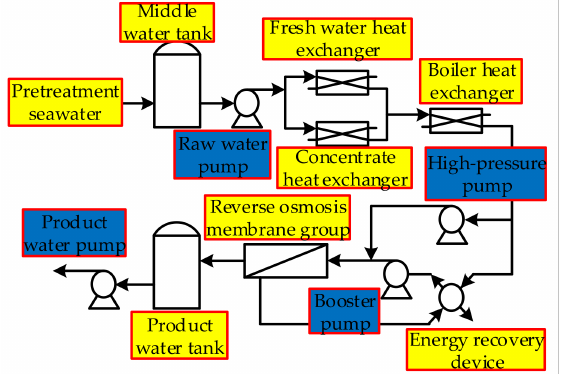
Figure 1. Process of reverse osmosis seawater desalination.